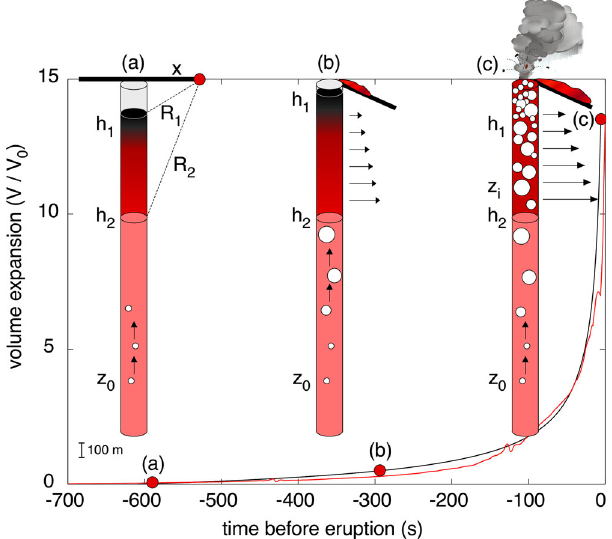
Fig. 5 Ground deformation and conduit dynamics. Conceptual model of the pre-eruptive process causing ground in fl ation lasting 610 s (red line) before the eruptive onset on 3 July 2019 and a the geometrical parameters used to locate the source with the open-conduit model36. In the initial phase ( a ), gas rising from depth ( zo ) expands, forcing the magma column towards the surface ( b ) and leading to a precursory emission of lava outside the vent. Ground deformation is caused by an increase in magmastatic pressure and/or pressurization at the base ( h2 ) of the viscous degassed magma at the top of the magma column ( h 1 and h 2 ) in response to the exponential growth (black line) of the gas (Eq. 2). c When the pressure induced by the highly vesiculated magma overcomes the tensile strength of the viscous magma mush 42, 44 , fragmentation occurs ( zi